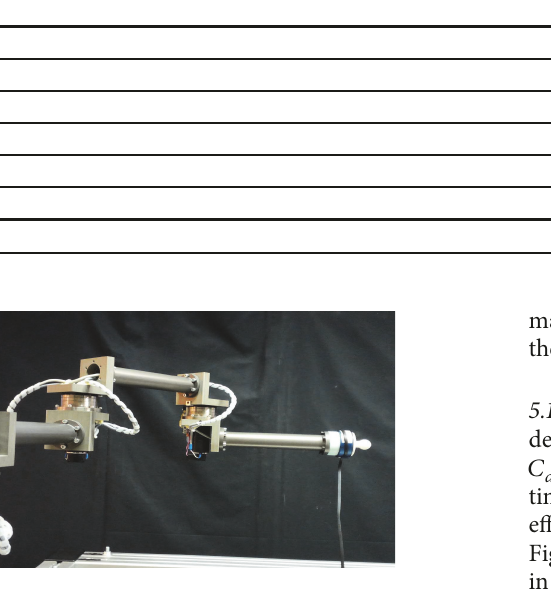
Figure 4: Robot manipulator in experiment